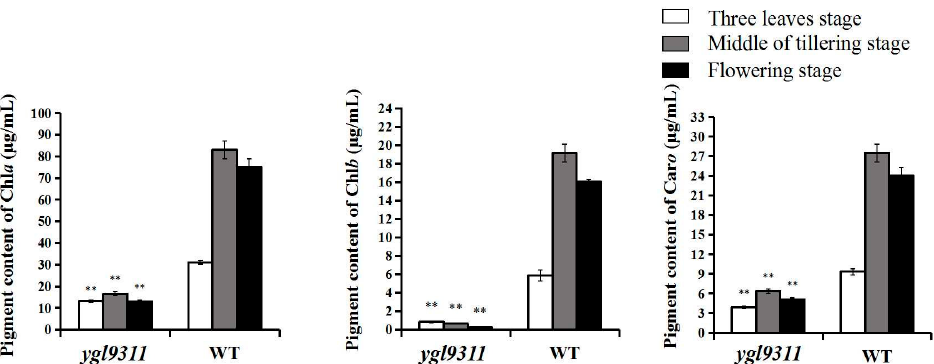
Figure 4. Photosynthetic pigment contents in leaves of the mutant ygl9311 and the wild-type parent 9311. Bars represent standard deviations of three independent experiments. Significant differences were determined by Duncan ′ s Multiple Range test.